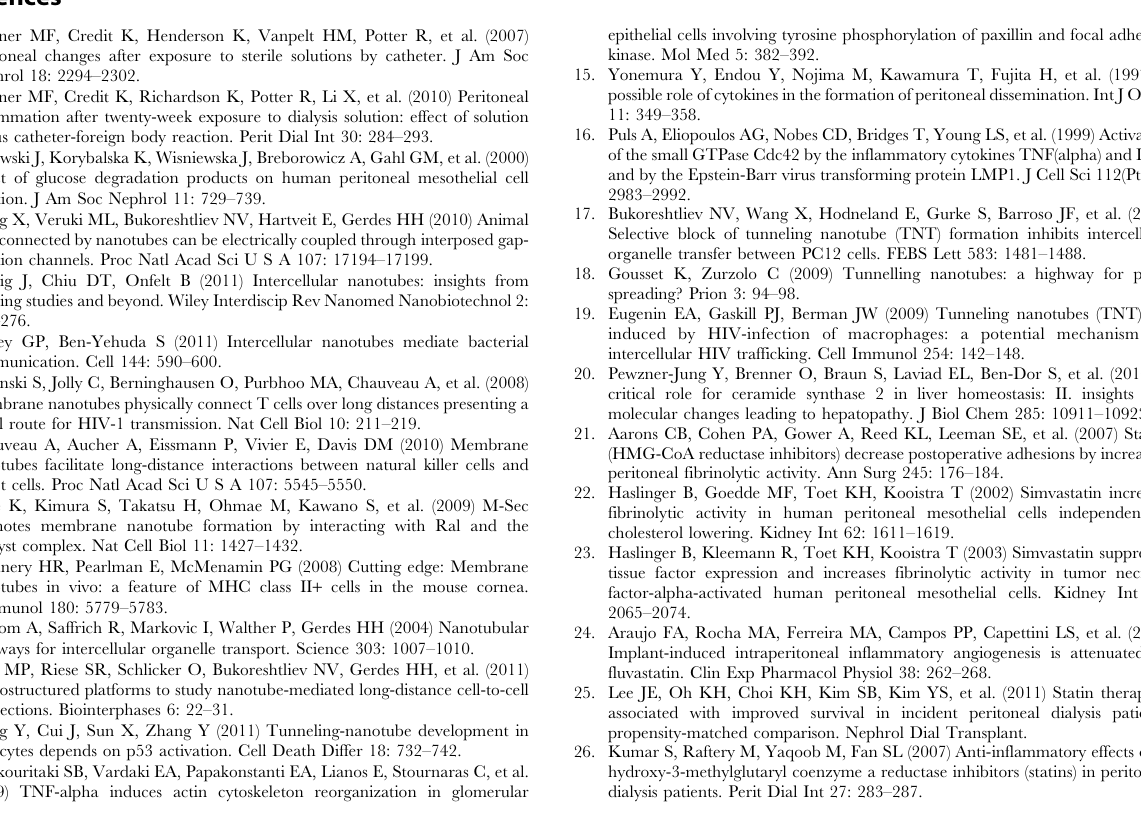
cell of a NT-connected cell-pair was selected (asterisk). The arrow points to the connecting NT. ( B ) Merged fluorescence picture showing the injected cell 5 min after injection. ( C ) Flow of the dye into the NT 10 min after injection (arrowhead). ( D ) 45 min after injection, the dye was detectable in the non-injected cell (arrowheads). Scale bars: 20 m m. Figure S2 NT numbers between HPMCs from CAPD- patients. Quantitative analyses of the NTs/cells ratio from 3 different individuals (Donors VII–IX) undergoing CAPD. Table S1 Patient characteristics. Peritoneal biopsies from 5 individuals (Donors I–IV, VI) and overnight bags from four PD- patients (Donor V, VII–IX) were collected as described.